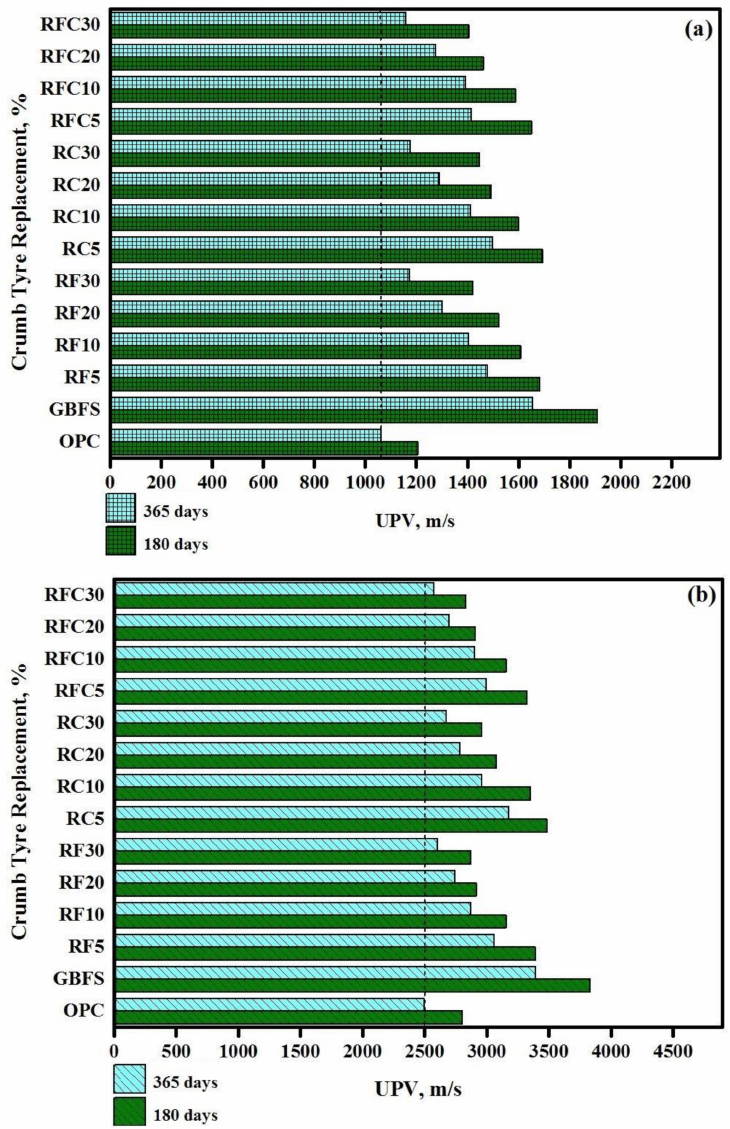
Figure 3. Ultrasonic pulse velocity (UPV) reading records of all studied specimens after 180 and 365-days of immersion in and ( a ) H 2 SO 4 and ( b ) MgSO 4